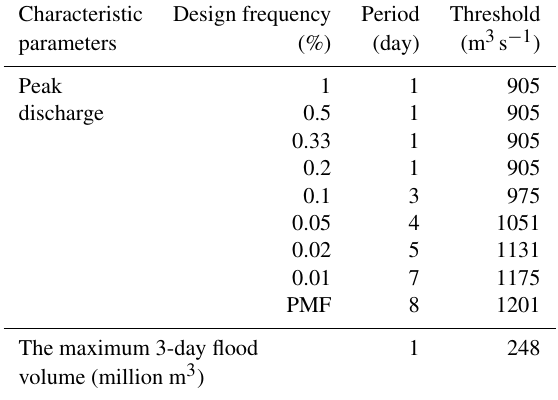
Table 1. Threshold of peak flow and 3 day flood volume.